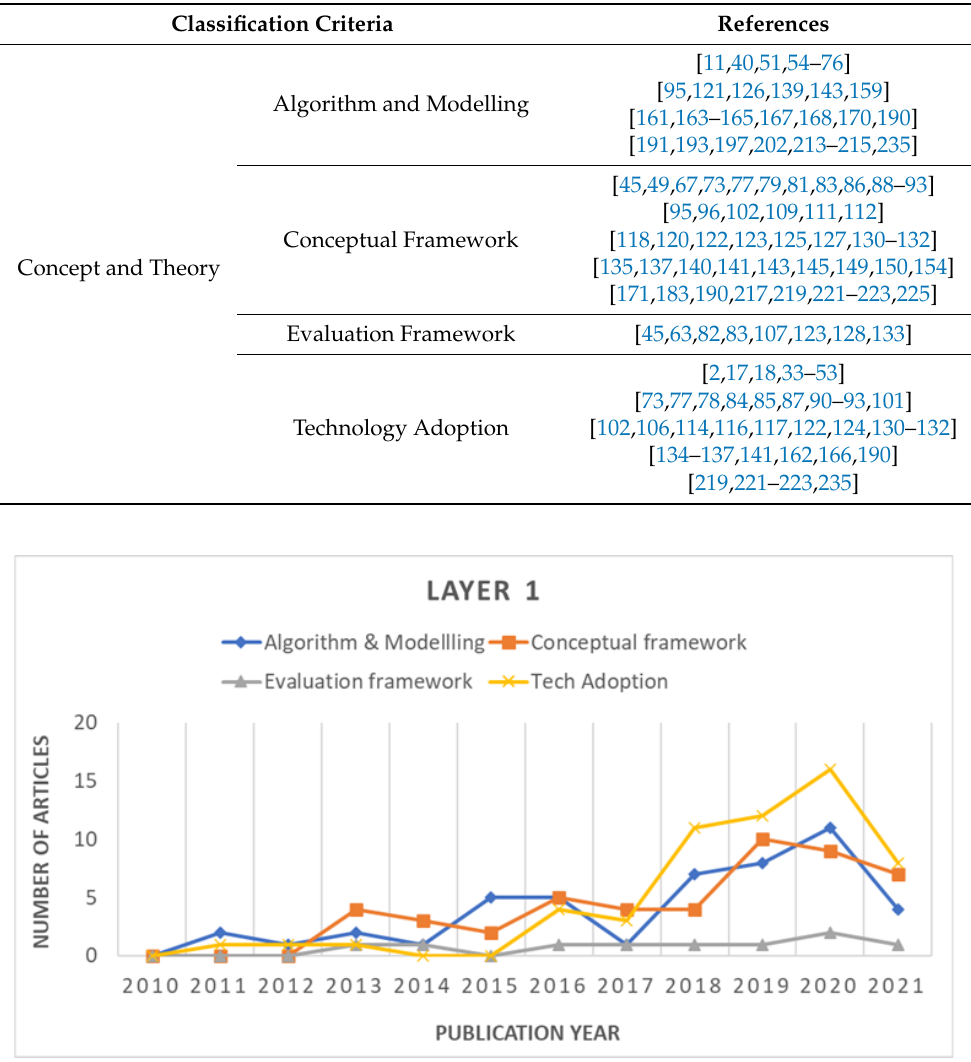
Figure 10. Number of articles in each category of layer 1 from 2010 to 2021.